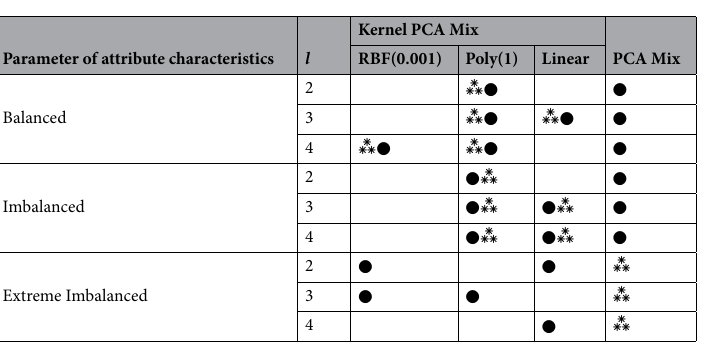
Table 4. Summary of Kernel PCA Mix and PCA Mix